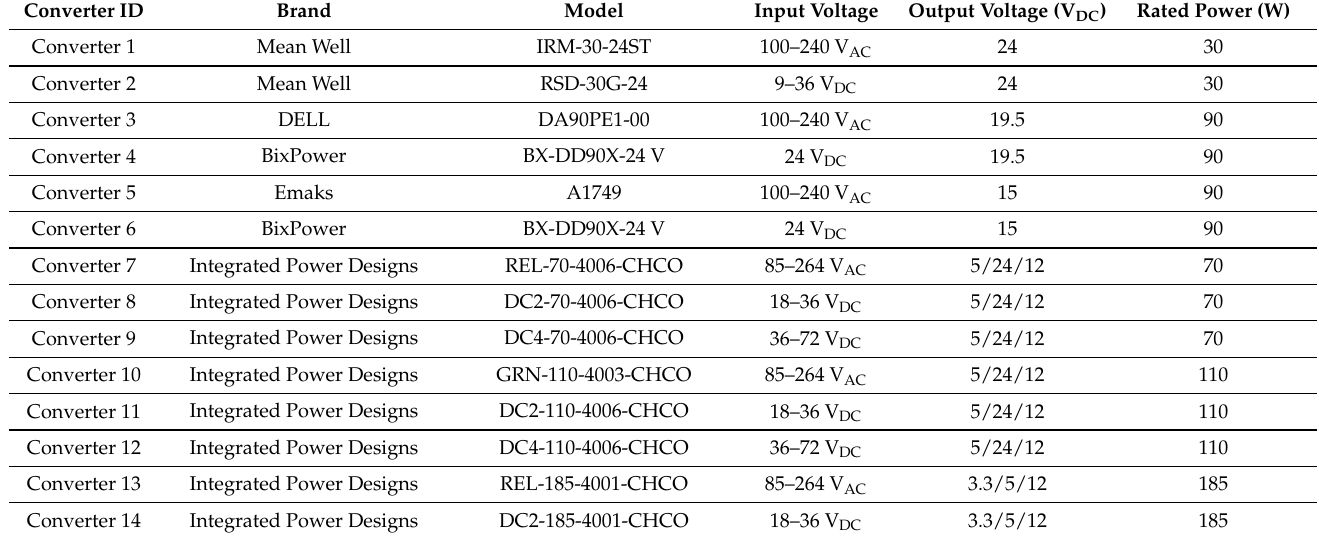
Table 1. AC/DC and DC/DC test